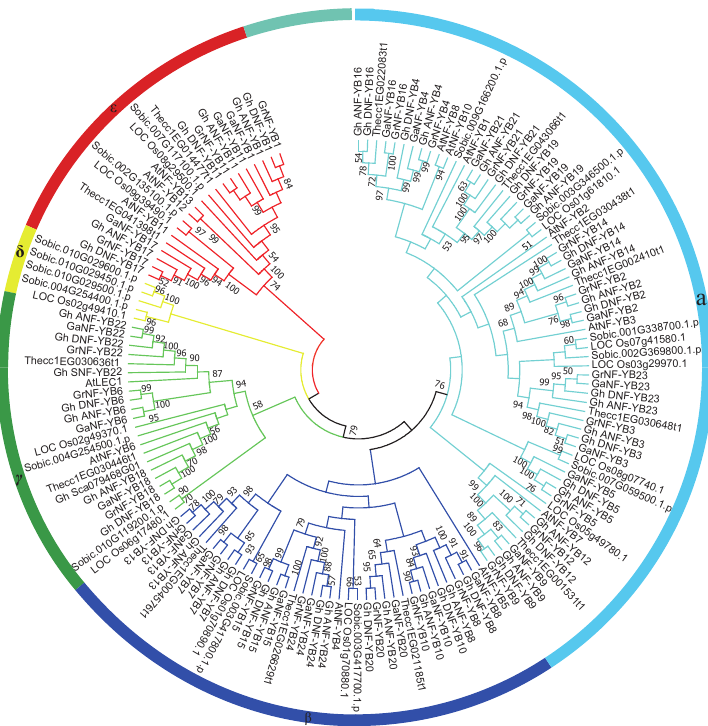
Figure 1. Phylogenetic relationships of NF-YB gene family. The analysis included full-length protein sequences from Gossypium hirsutum , Gossypium arboretum , Gossypium raimondii , Arabidopsis , Oryza sativa